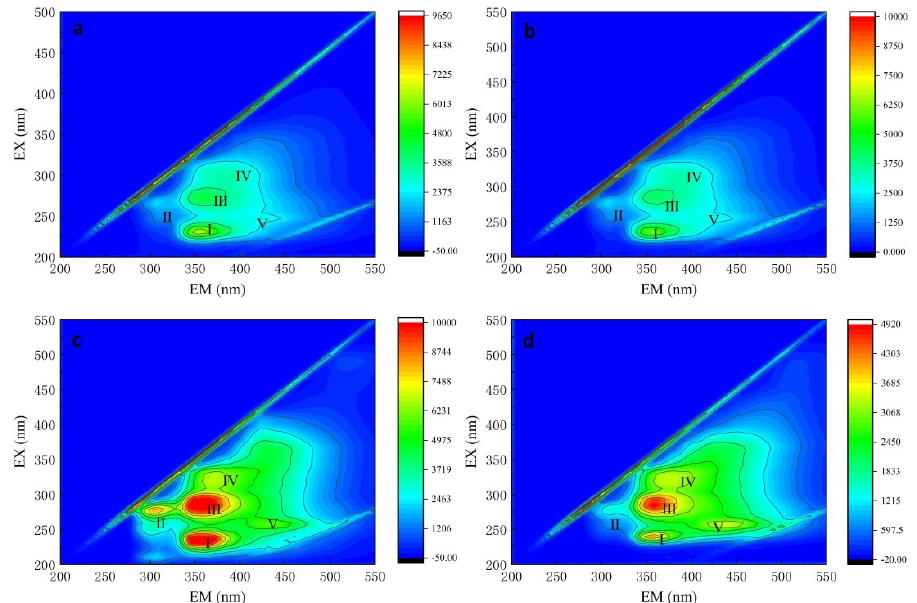
Figure 2. Three-dimensional fluorescence spectrums of influent and effluent in the acclimation system. (The proportion of SBECW in the influent was 50% ( a ); The proportion of SBECW in the effluent was 50% ( b ); The proportion of SBECW in the influent was 100% ( c ); The proportion of SBECW in the effluent was 100% ( d ); Emission wavelength (Em) from 200 nm to 550 nm (excitation slit: 5 nm band-pass) and excitation wavelength (Ex) from 200 nm to 450 nm (emission slit: 5 nm band-pass)).